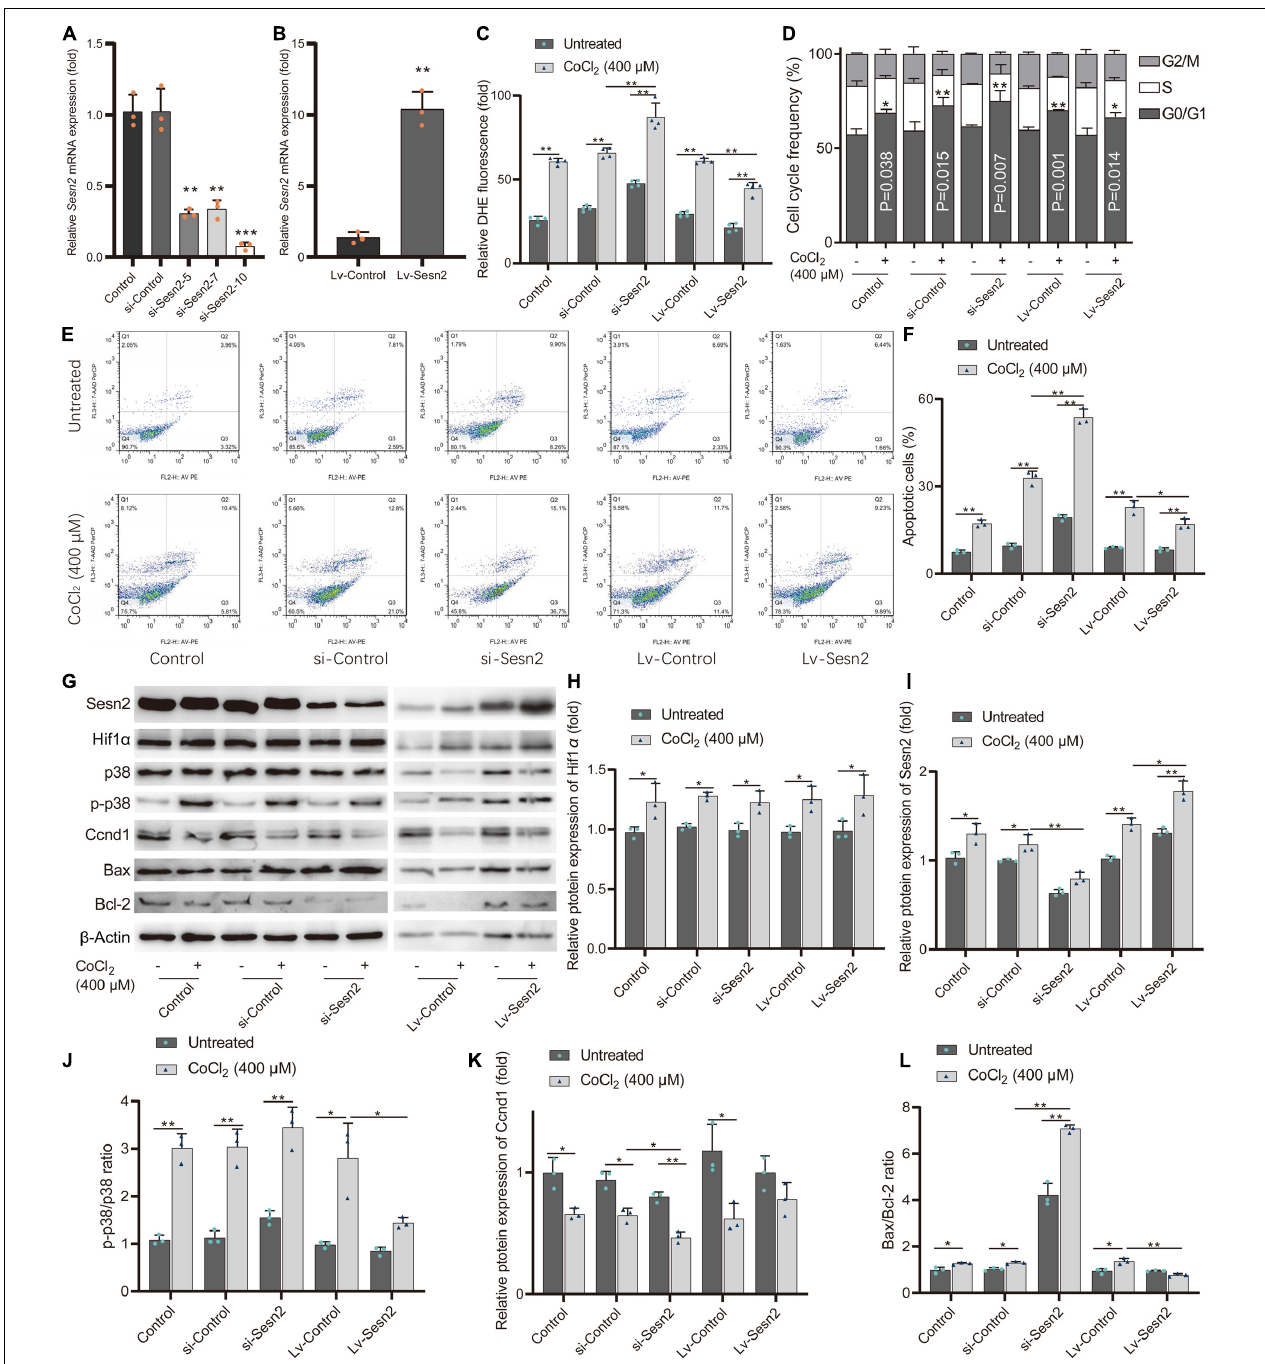
FIGURE 6 | Sesn2 protects H9c2 cells from hypoxia-mimetic cobalt chloride-induced cell injury. (A) Sesn2 relative expression level in H9c2 cells after transfection with RNA interference targeting Sesn2 (si-Sesn2-5, si-Sesn2-7, and si-Sesn2-10). ** P < 0.01, *** P < 0.001 against negative control small interfering RNA (si-Control). (B) Sesn2 relative expression level in H9c2 cells after transfection with empty vector (LV-Control) and overexpression vector (LV-Sesn2). ** P < 0.01 against LV-Control. (C) Effects of knockdown or overexpression of Sesn2 on cellular ROS with or without cobalt chloride-induced hypoxia. The DHE fluorescence intensity represents ROS concentration. (D) Effects of knockdown or overexpression of Sesn2 on cell cycle distribution with or without cobalt chloride-induced hypoxia. (E) Apoptotic cells were quantified by Annexin V-PE/7-AAD dual staining followed by flow cytometry. (F) Effects of knockdown or overexpression of Sesn2 on cell apoptosis with or without cobalt chloride-induced hypoxia. (G) Effects of knockdown or overexpression of Sesn2 on the levels of Hif1 α , Sesn2, p38, p-p38, Ccnd1, Bax, and Bcl-2 with or without cobalt chloride-induced hypoxia. (H) The relative protein expression levels of Hif1 α . (I) The relative protein expression levels of Sesn2. (J) The ratio of p-p38/p38. (K) The relative protein expression levels of Ccnd1. (L) The ratio of Bax/Bcl-2. ** P < 0.01, * P < 0.05. siRNA, small interfering RNA. Lv-gene, gene-overexpressed lentiviral vector.